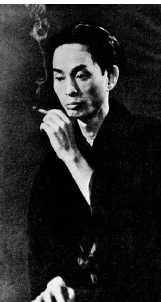
Figure 1. Yasunari Kawabata (https://en.wikipedia.org/wiki/Yasunari_Kawabata#/media/File: Yasunari_Kawabata_c1932.jpg, public domain).